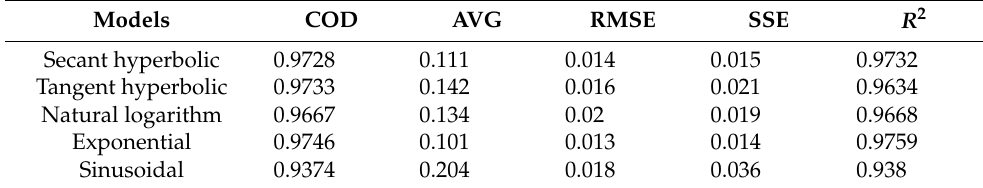
Table 6. Precision and performance of the models for ∆ H prediction (testing data).